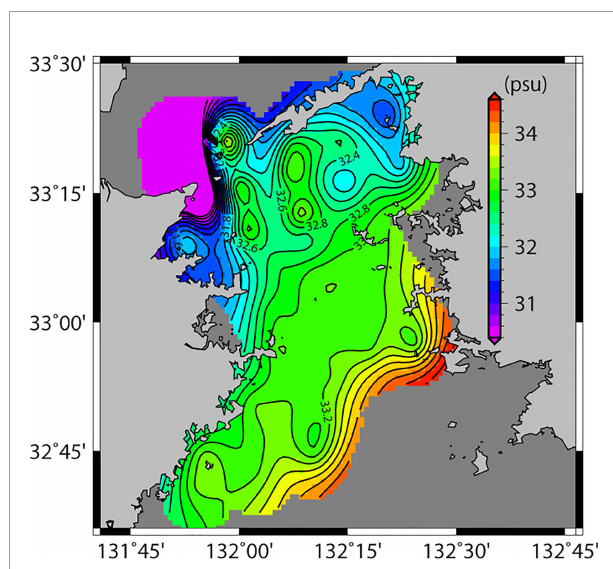
FIGURE 8 | Horizontal distribution of sea surface salinity calculated by the numerical model for the observations at the same location and time as those in Figure 6